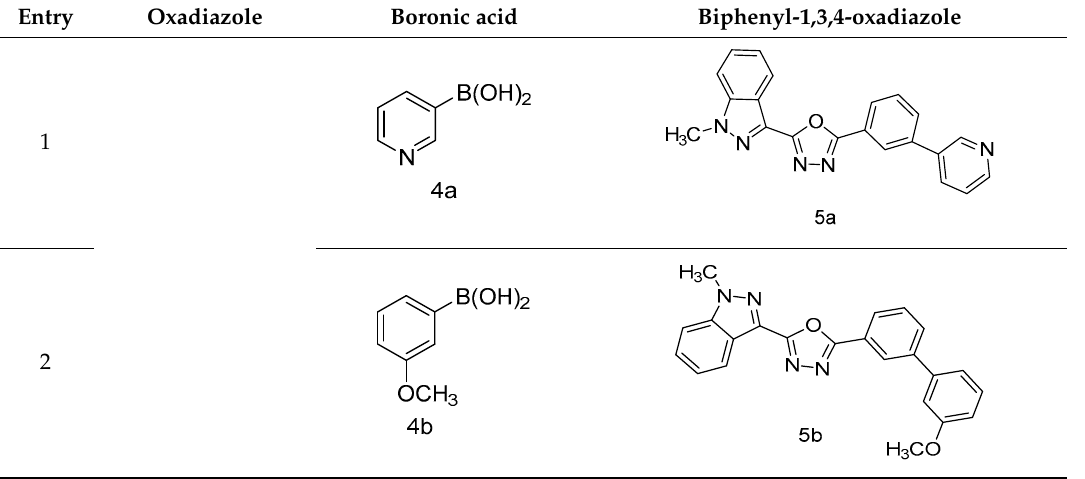
Table 1. List of newly synthesized oxadiazoles.